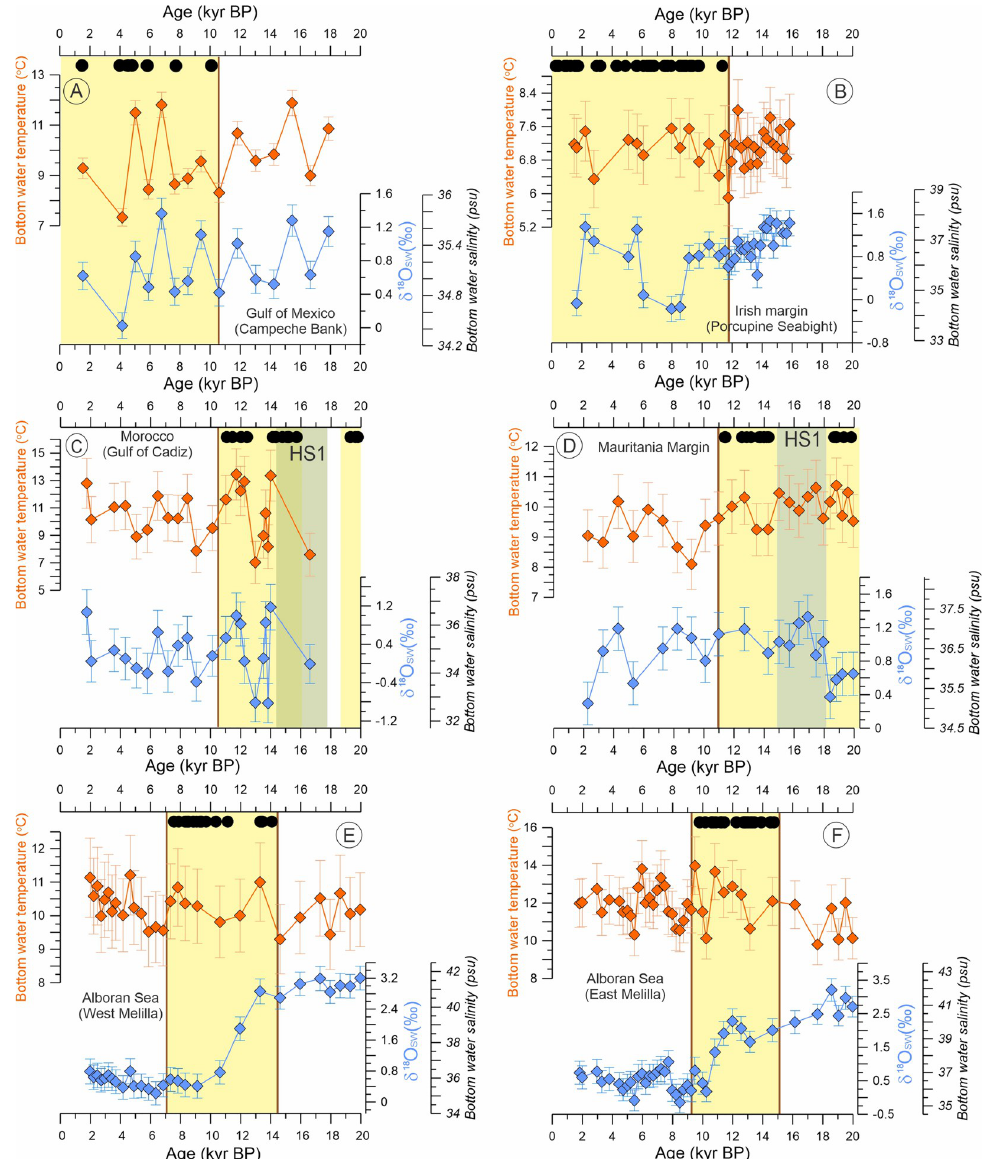
Fig 2. Long-term development of Lophelia pertusa in the North Atlantic and the Mediterranean Sea superimposed on the temperature and salinity changes during the last 20 kyr. The occurrence of L. pertusa in each region is indicated by black dots at the top, reflecting coral fragments dated by the U/Th and/or AMS 14 C method (see references in the S2 Table), while the yellow vertical bars highlight periods of L . pertusa proliferation with their limits defining on- and offsets of coral growth (vertical brown lines). Bottom-water temperature and salinity were estimated using paired Mg/Ca ratio and stable oxygen isotope ( δ 18 O) measurements on benthic foraminifera shells (see S1 Text). While bottom-water temperature is calculated from Mg/Ca ratios (for details, see S4 Table), the δ 18 O sw record is used here as a proxy for salinity. The greenish bar indicates the period of HS, which (partly) overlaps with periods without coral growth off Mauritania and Morocco. The brown vertical line indicates the transition between on and offset of CWC proliferation. The underlying data for this figure can be found in https://doi.org/10.1594/PANGAEA.932775. BP, before present; HS1, Heinrich Stadial